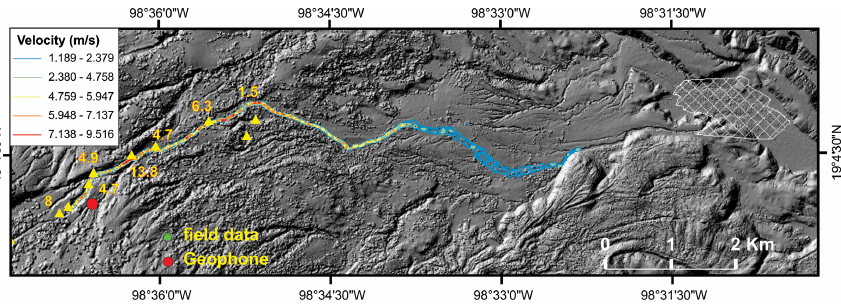
Figure 7. Velocity distribution obtained during flow simulation (ms − 1 ). Yellow triangles refer to the locations of flow velocity calculated by Muñoz-Salinas et al. (2007) used here for